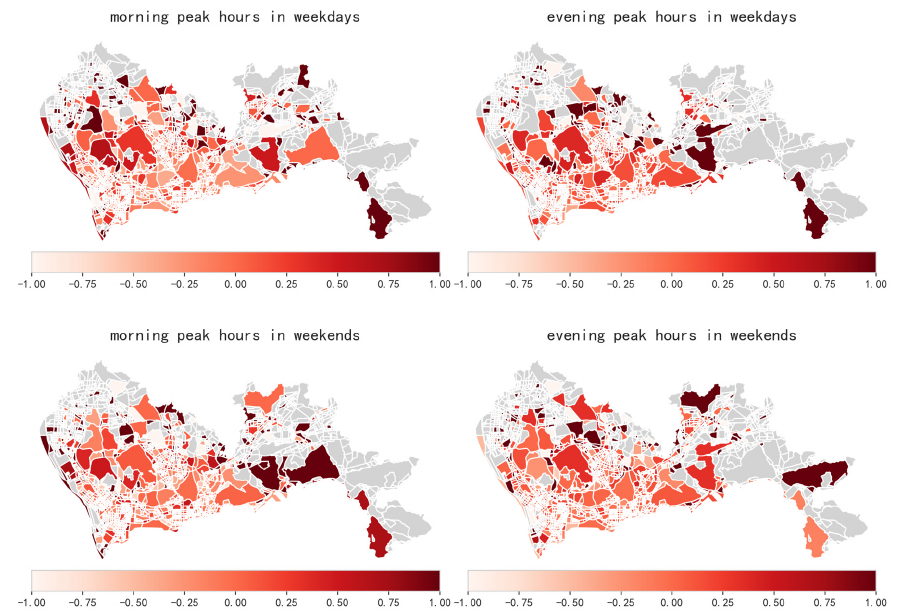
Figure 6. The map of taxis mobility index during the peak periods (the geographical background is obtained by overlaying roads and administration boundary of Shenzhen city).